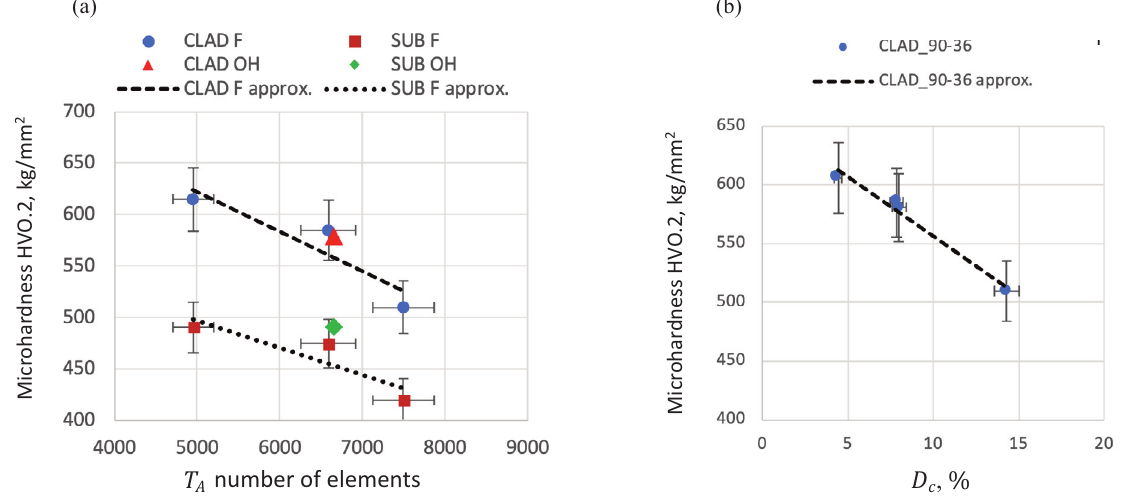
Fig. 9. Dependence of the HV value on 𝑇 𝐴 at α = 36° and dependence of the HV value on 𝐷 𝑐 .